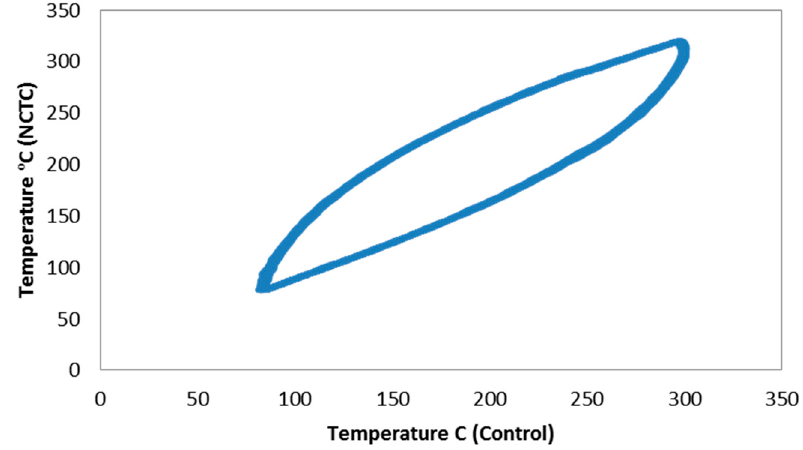
Figure 3. Relationship between the centre gauge thermocouple and the close proximity mounted thermocouple over 50 cycles.